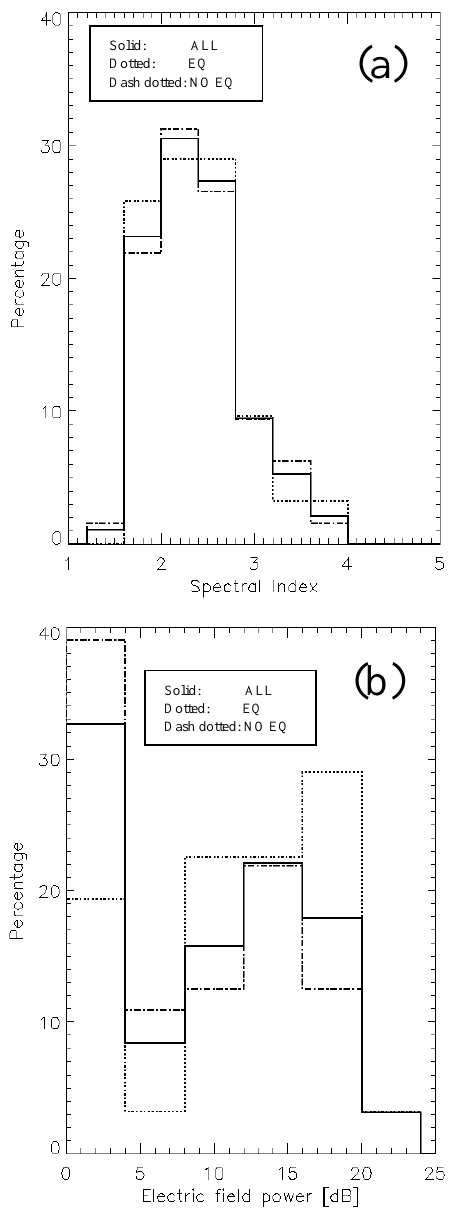
Fig. 7. Probability distributions of ( a ) spectral index and ( b ) elec- tric field power of the electric field bursts. Solid lines represent all events, dotted lines are for bursts with major seismic activities, and dash dotted lines are for bursts without seismic